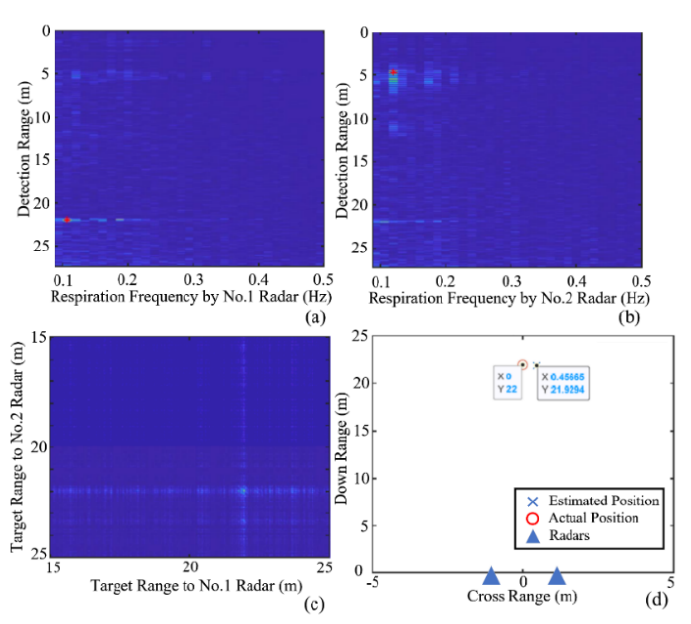
Figure 13. The experiment A result. ( a , b ) The output range-frequency images using the normal FFT-based respiration detection methods using the echoes from a single radar. ( c ) The output two-dimensional (2D) slice (range × range) image for the specific respiration frequency. ( d ) The positioning result calculated by the radar system is compared with the actual position of the